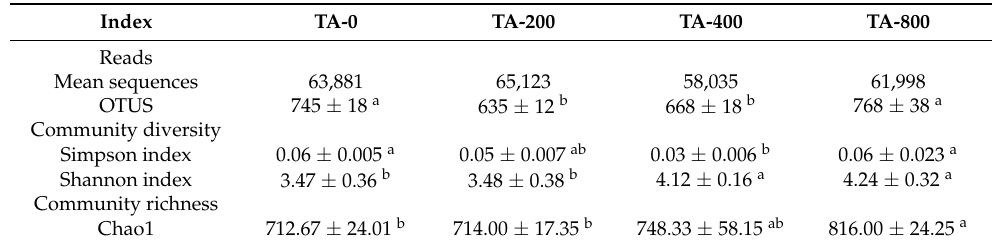
Table 3. Alpha diversity of intestinal microbial of L. vannamei that were fed the control and TA diets for 56 days.